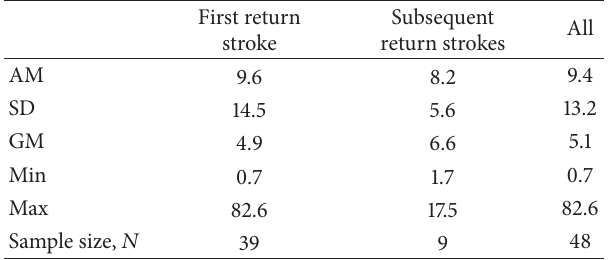
Table 3: Statistical summary of 10–90% rise time for 48 positive return